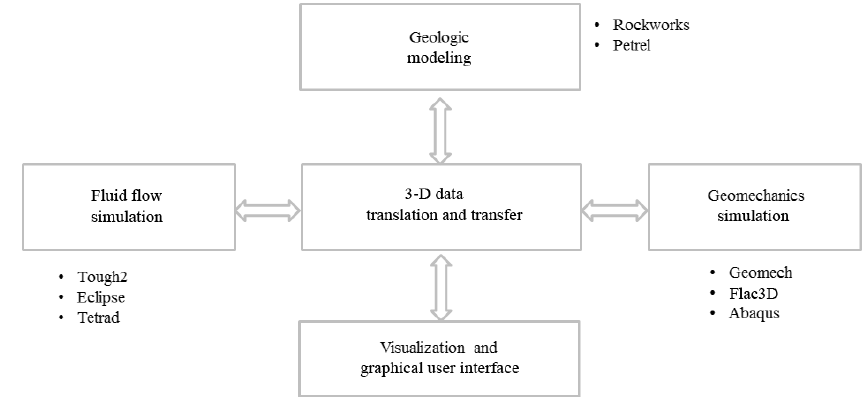
Figure 2. Workflow procedures developed by Geomechanics Technologies to create consistent and integrated modeling of geological condi- tions, geomechanical processes, and fluid and heat flow processes.